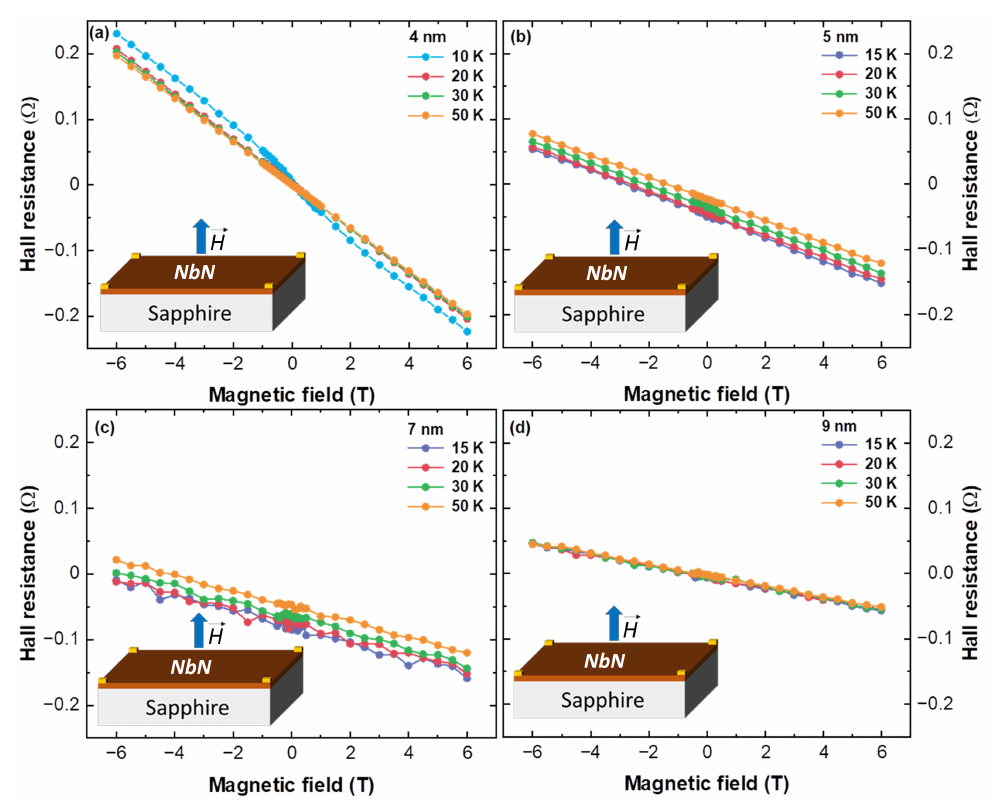
Figure 2. Hall resistance measured in Van der Pauw geometry at 10 K, 20 K, 30 K, and 50 K for ( a ) 4 nm, and at 15 K, 20 K, 30 K, and 50 K for ( b ) 5 nm, ( c ) 7 nm, and ( d ) 9 nm NbN thin films on sapphire. As expected, for a fixed temperature, the slope of magnetic-field-dependent Hall resistance of n -type conducting NbN thin films decreased with increasing thickness of the NbN thin films. Except for the Hall resistance of the 4 nm NbN thin film at 10 K, which was close to the critical temperature of the 4 nm-thick NbN thin film. All Hall resistance curves were also linear and in the magnetic field range − 1 T to +1